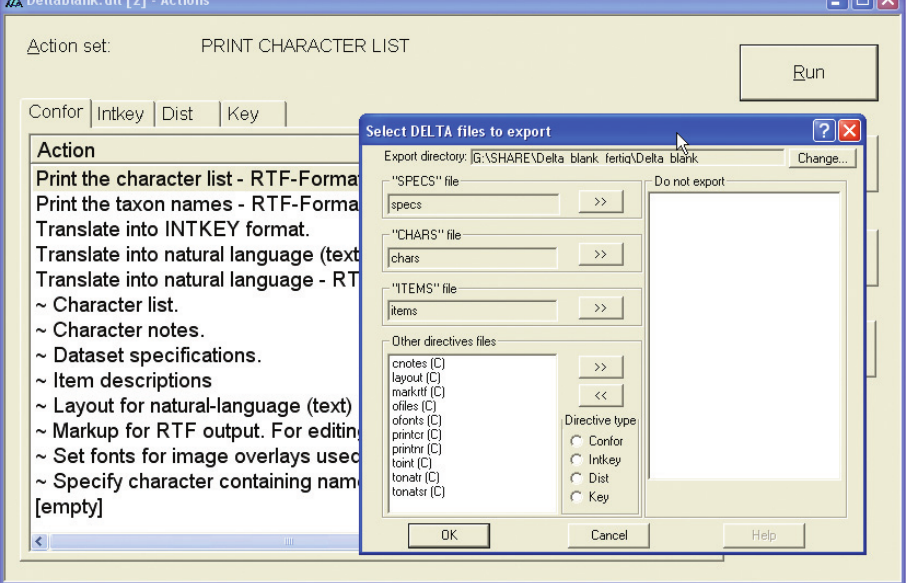
Figure 25. Confor in the DELTA Editor asks the user to make a selection of directive fi les being